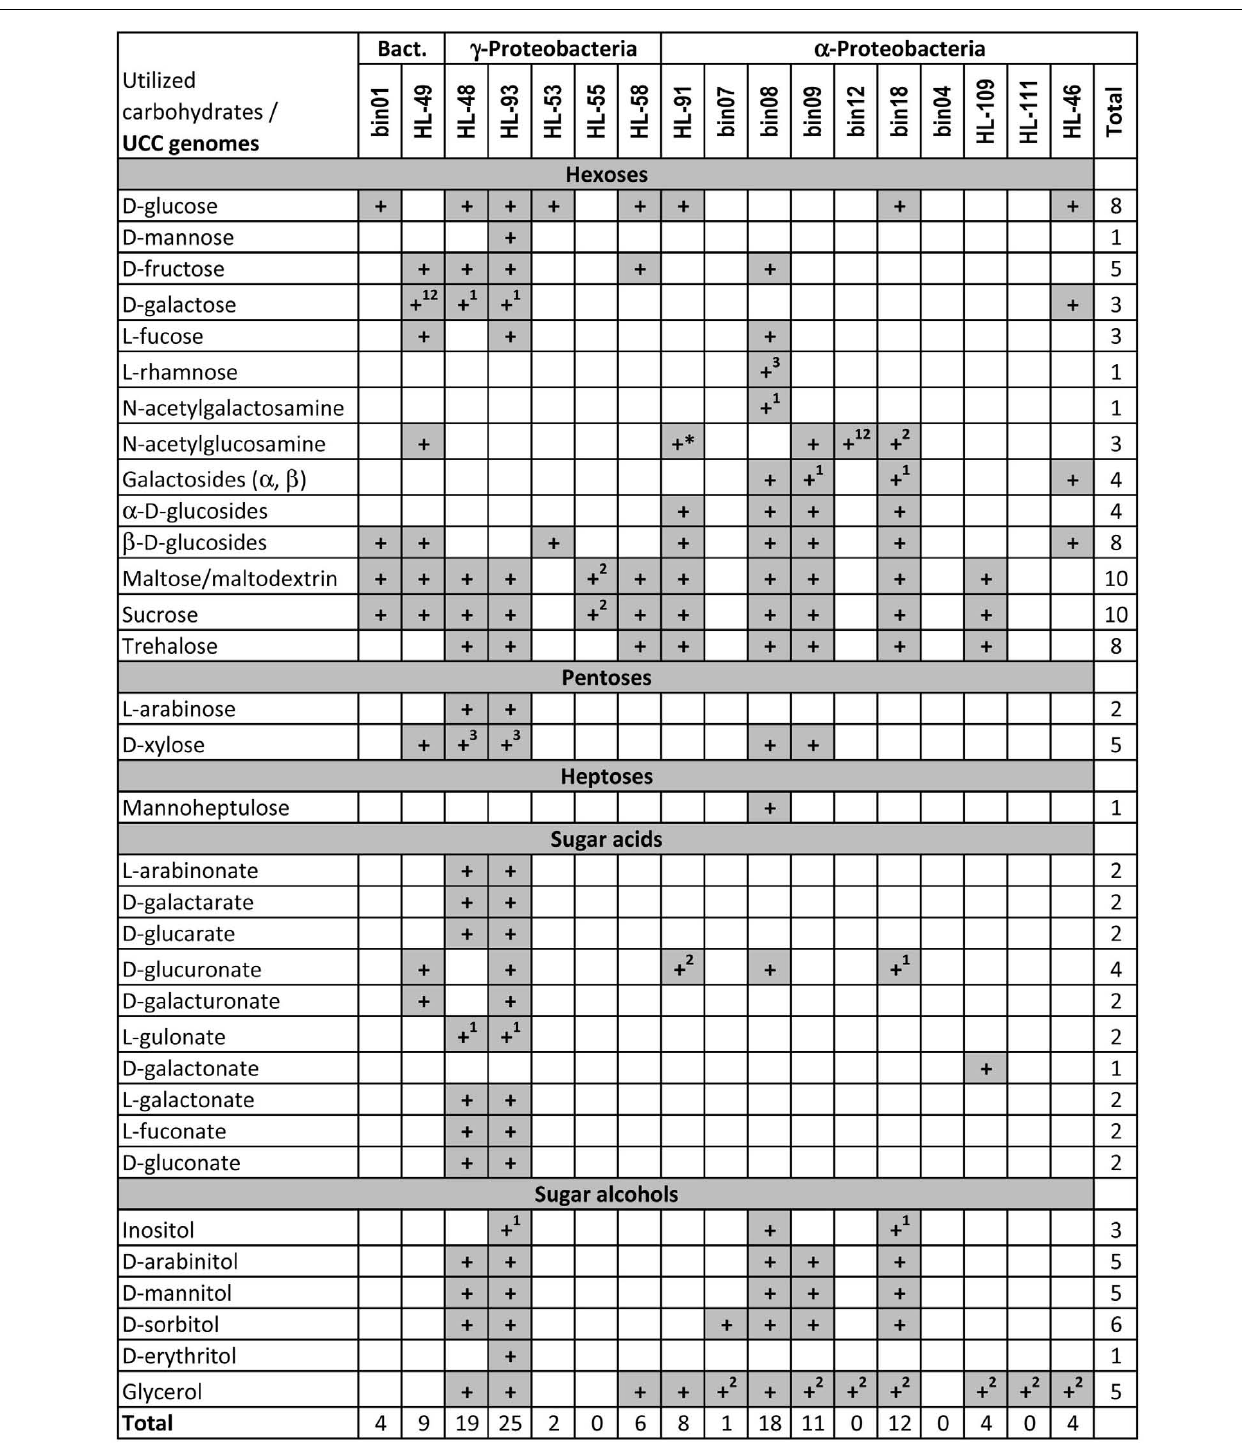
FIGURE 1 | Predicted carbohydrates utilization capability of heterotrophic unicyanobacterial consortia (UCC) organisms. Aliases for analyzed UCC genomes are described in Table 1 . The ability of UCC species to grow on a panel of sugar substrates was predicted based on the presence of the respective reconstructed pathways and carbohydrate-specific transporters in their genomes. Superscript numbers indicate that: (1) the reconstructed pathway contains a missing enzyme; (2) the catabolic pathway is present but carbohydrate-specific transporter is missing; (3) the catabolic pathway includes uncharacterized enzymes with unclear biochemistry. Asterisk indicates the predicted ability to utilize N- acetylmuramic acid (the ether of lactic acid and N -acetylglucosamine), which is based on the presence of MurQ etherase and the complete N -acetylglucosamine catabolic pathway.